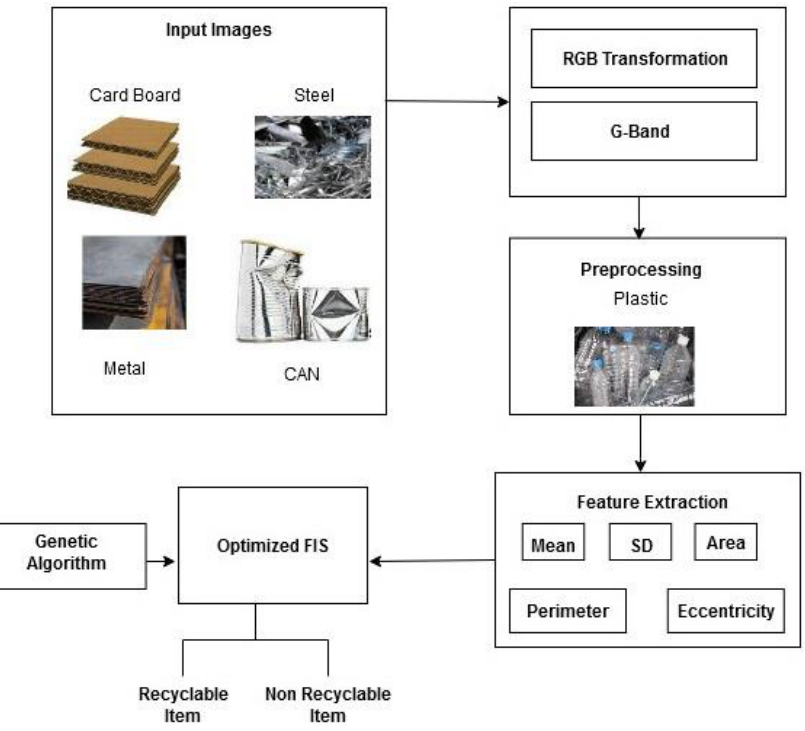
Figure 5. Proposed image classification model.